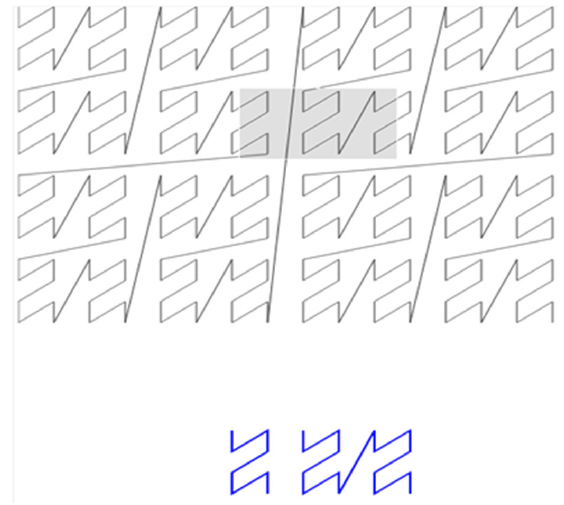
Figure 8. Ranges of Morton codes contained in a query region.